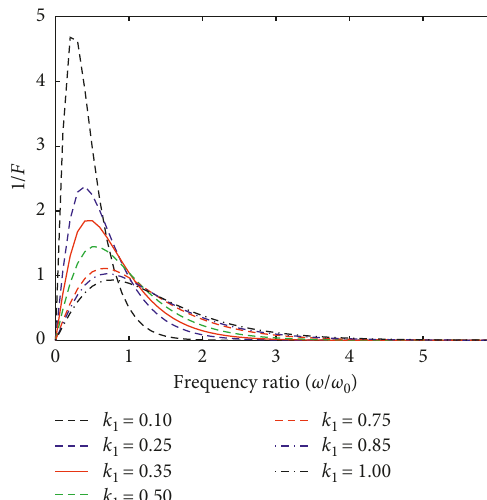
Table 3: System responses for different typical points ( F � 1.75N). Excitation frequency The largest Lyapunov Motion Figure 16: Chaotic threshold curve with different k Points (rad/s)